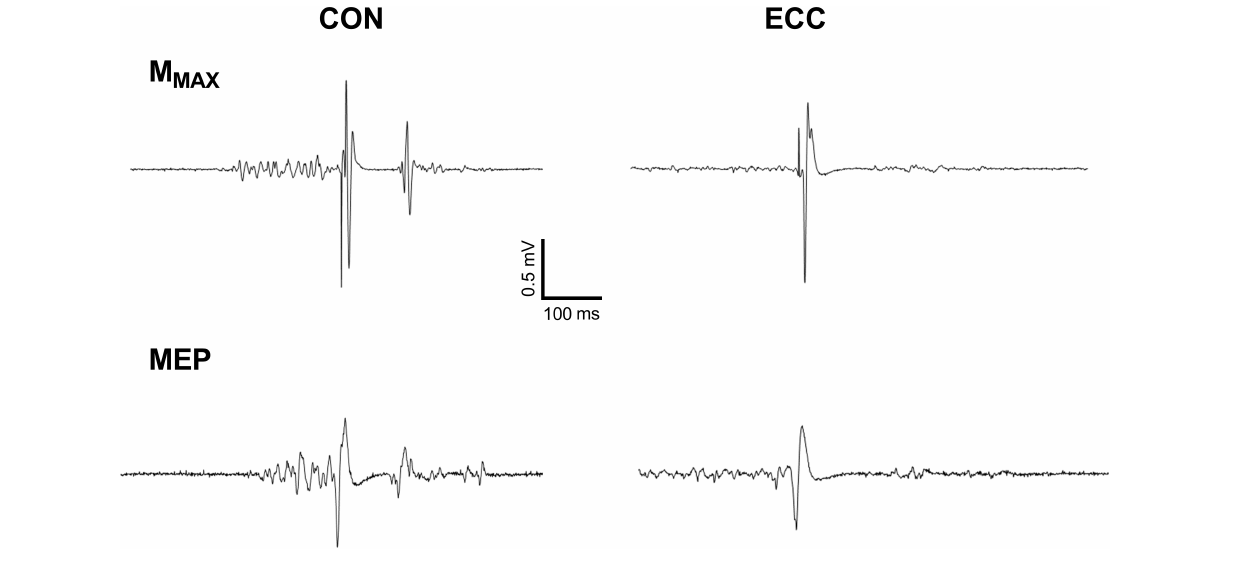
Frontiers in Physiology |